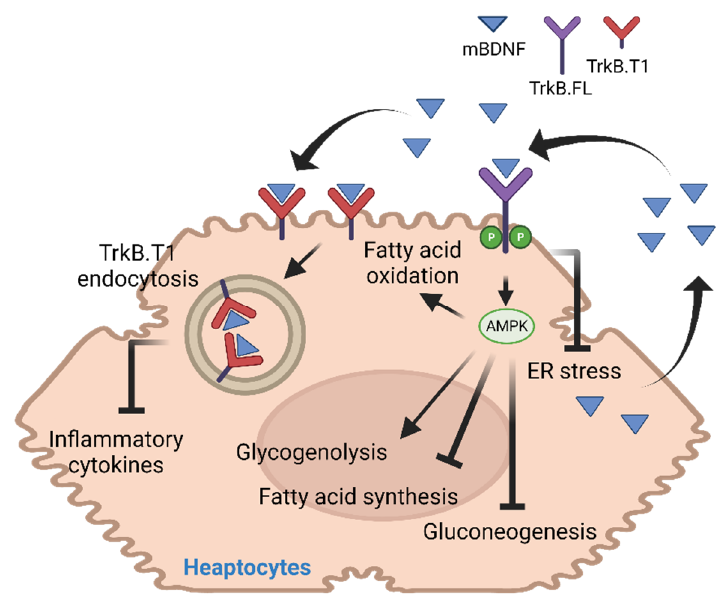
Figure 2. Functional activities of mBDNF in the liver.